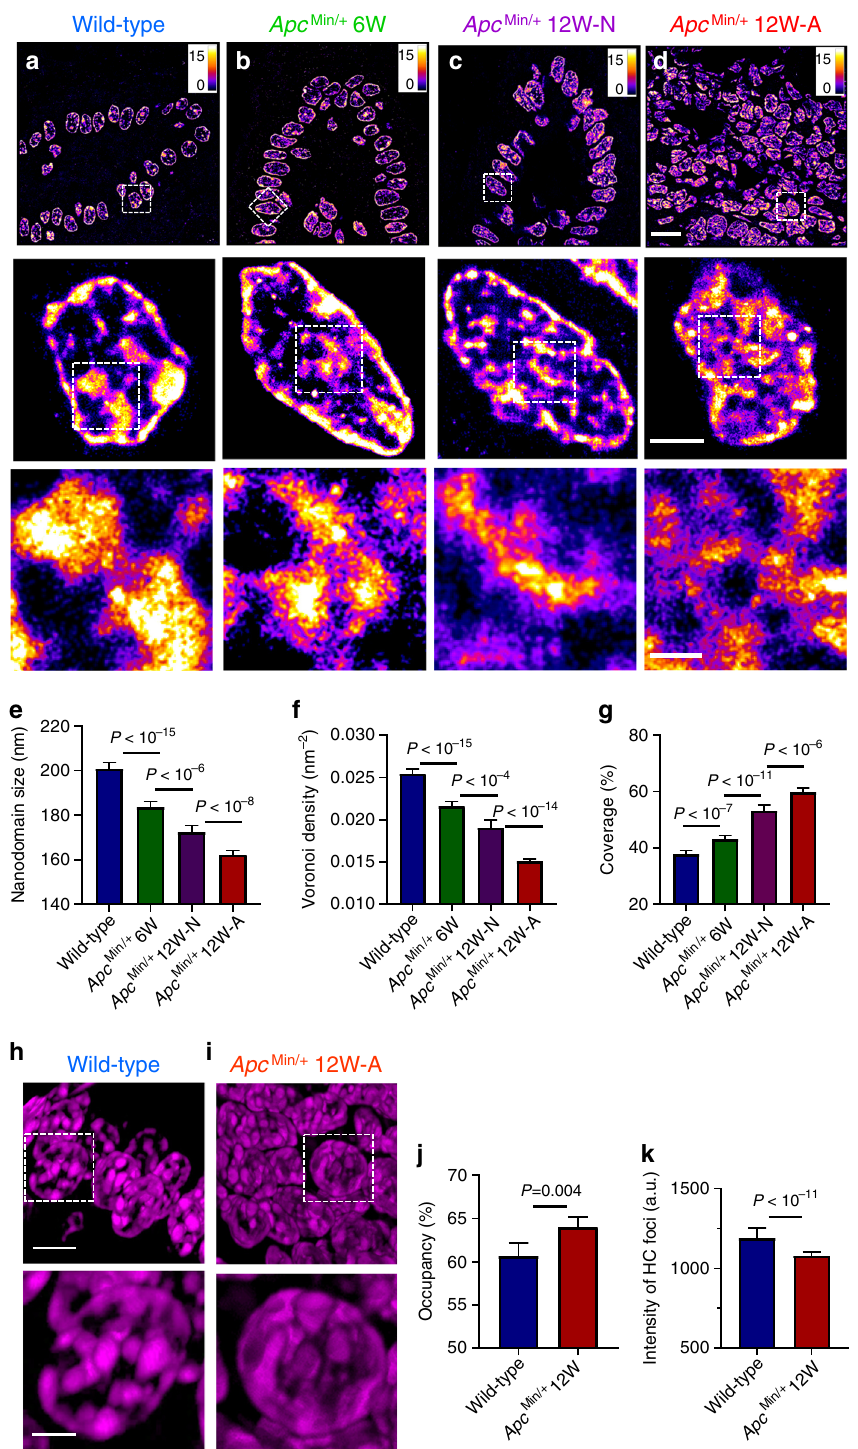
Fig. 2 Super-resolution imaging of DNA in Apc Min/ + mouse model. a – d STORM images of DNA folding from normal cells from wild-type, histologically normal-appearing cells from 6-week and 12-week Apc Min/ + , and tumor cells from 12-week Apc Min/ + mice. Scale bars: 10 µ m, 2 µ m and 500nm in the original and magni fi ed images, respectively. e – g The statistical analysis of DNA nanodomain size ( e ), the local density of DNA quanti fi ed by Voronoi polygon density ( f ) and percentage of occupied DNA domains for each nucleus ( g ) in normal cells from wild-type mice ( n = 72 cells), from 6-week ( n = 104 cells) and 12-week Apc Min/ + mice ( n = 81 cells) and tumor cells from 12-week Apc Min/ + mice (224 cells). Error bars, mean±95% CI. Cell nuclei from three mice for each category were used in the above analysis, as described in the fi gure caption of Fig. 1. h , i 3D-SIM images of DAPI-stained DNA folding in normal cells from wild-type mice and tumor cells from 12-week Apc Min/ + mice. Scale bars: 5 and 2 µ m in the original and magni fi ed images, respectively. j The occupancy of DNA de fi ned by the total volume of DNA over the entire 3D volume of each nucleus, calculated from the 3D-SIM images. k The average fl uorescence intensity from each of the condensed region of heterochromatin (HC) foci in 3D-SIM images. Cells from wild-type mice ( n = 33 cells) and tumor cells from 12-week Apc Min/ + mice ( n = 61 cells) were used in the 3D-SIM image analysis. Error bars: mean±95% con fi dence interval (CI). All P values were determined using Mann − Whitney